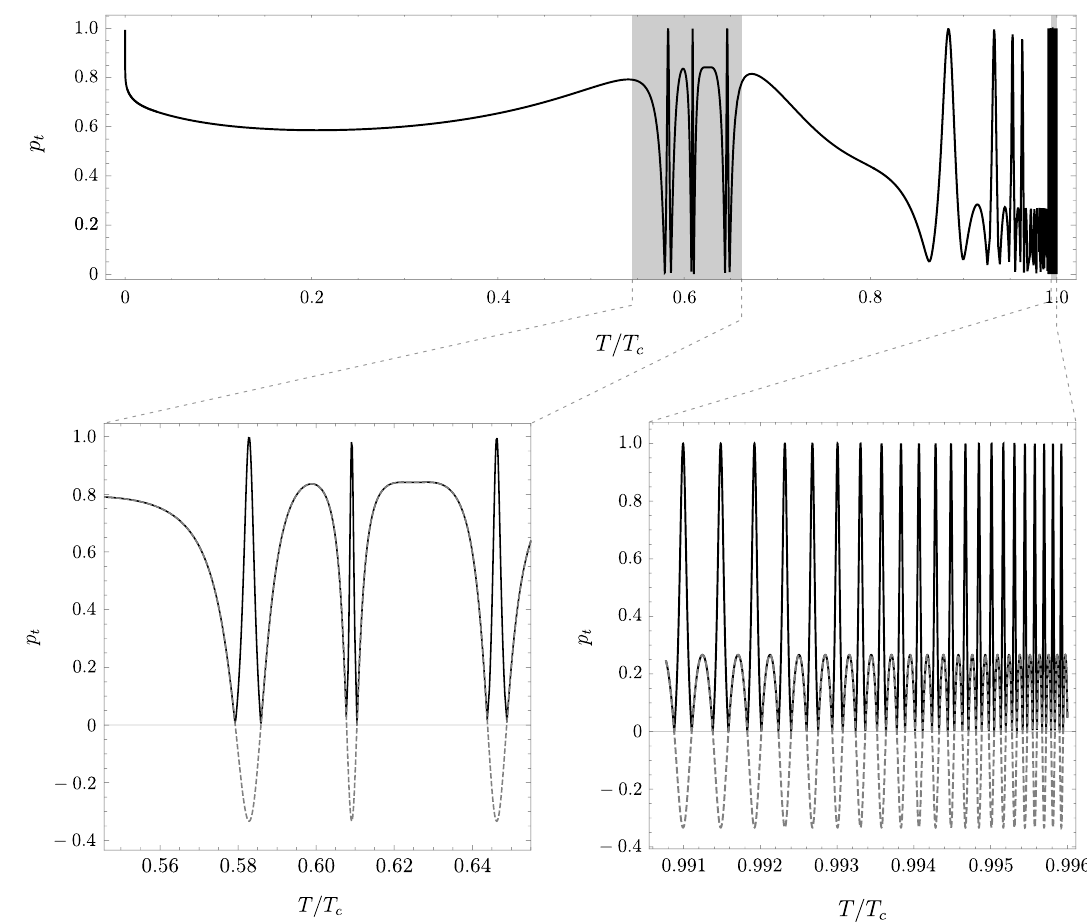
Figure 8: The Kasner exponent p lating regions have been blown up in the lower two figures. In the lower figures we have also shown the Kasner exponent p int